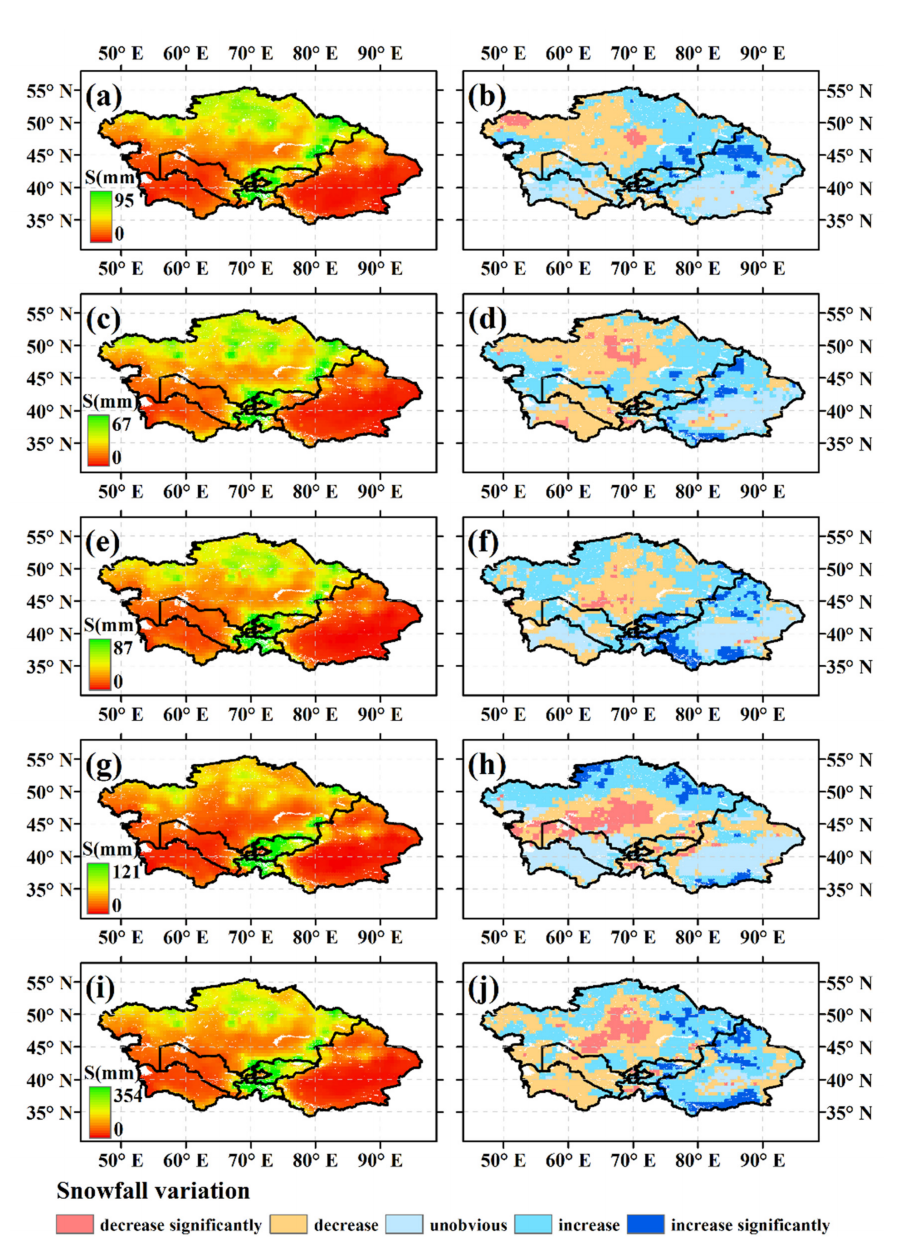
Figure 6. Multi-year mean snowfall and its variation in December ( a , b ), January ( c , d ), February ( e , f ), March ( g , h ), and winter ( i , j